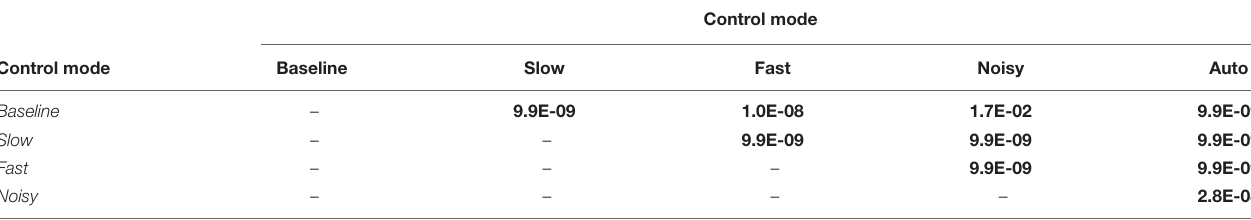
TABLE 3C | Post hoc comparisons ( p -value) between control modes for total acceleration.